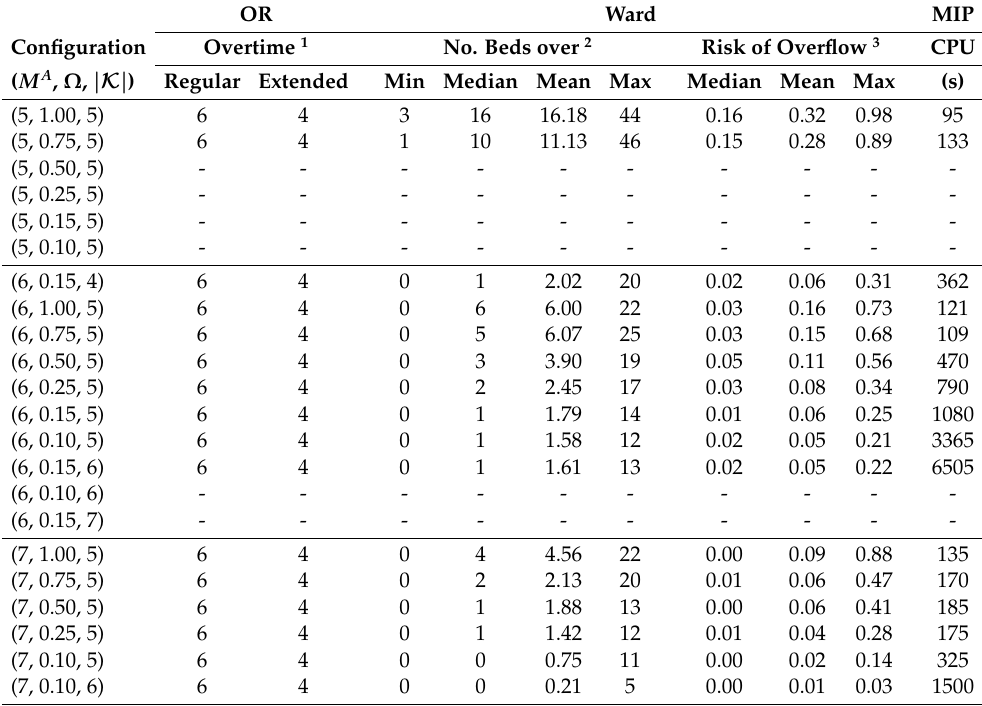
Table 2. Quality of solutions and computational requirements for different configurations of ( M A , Ω , |K| ) for the ward combination optimization (WCO). Here, M A denotes the maximum number of staffed ward beds, Ω denotes the limit on the likelihood that a ward combination exceeds the number of staffed ward beds and |K| denotes the number of probability